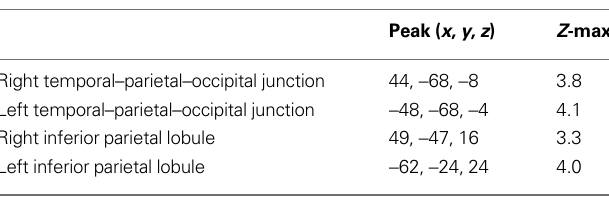
Table 6 | Self-Lose $4 > Charity-Lose $4.